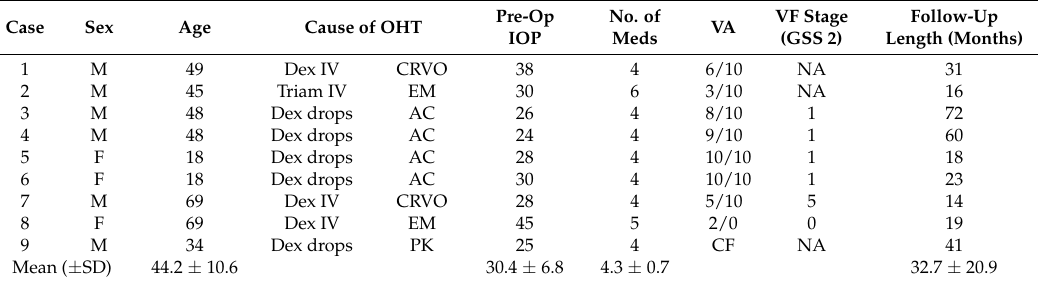
Table 1. Patient data before